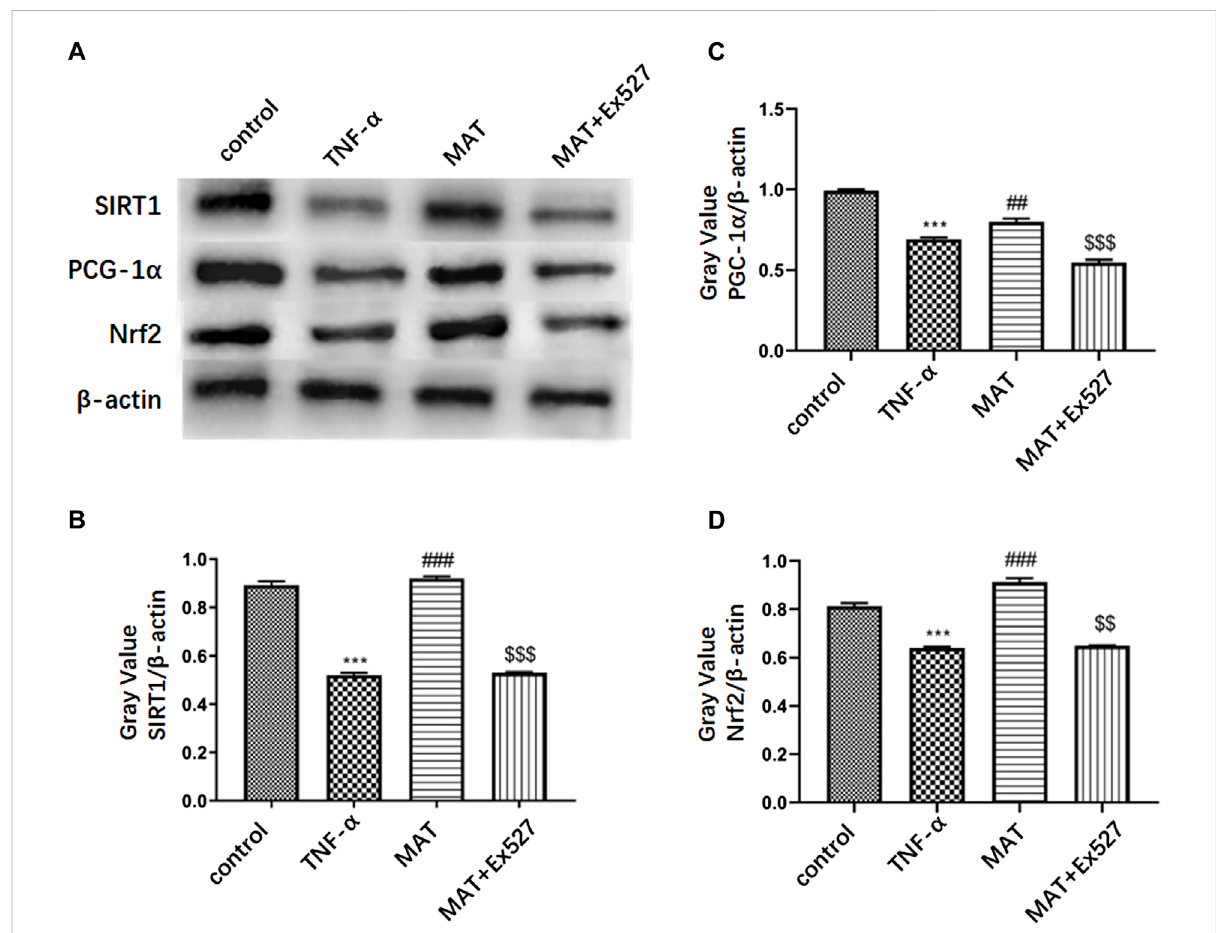
MATcouldpromoteNrf2/PCG-1 α expressioninRGC-5throughupregulatingSIRT1expression. (A) PCG-1 α andNrf2proteinexpressioninRGCcells treated by TNF- α were attenuated compared to control group, as well as SIRT1 expression. MAT co-treatment could improve the expression of SIRT1, PCG-1 α and Nrf2 signi fi cantly. This effect could be revised by EX527, an SIRT1 inhibitor. (B-D) Quantitative analysis of the relative expression of each molecule. Symbols represent mean ± SD; ** p < 0.01, *** p < 0.001, comparison between control and TNF- α groups. ## p < 0.01, ### p < 0.001, comparison between TNF- α and MAT groups. $$ p < 0.01, $$$ p < 0.001 comparison between MAT and MAT+EX527